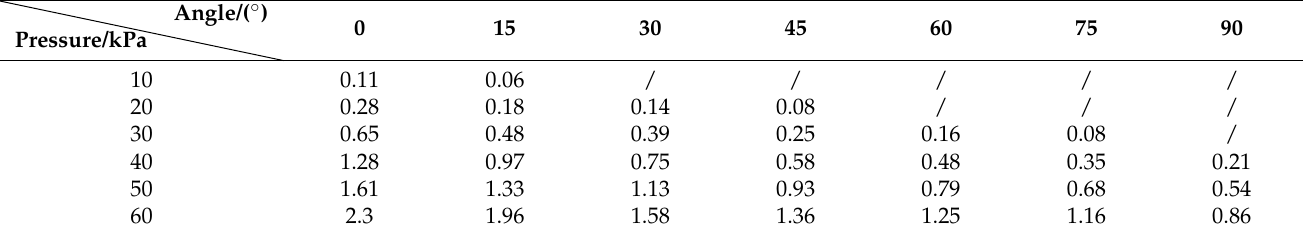
Table 2. Output force at the end of the soft actuator with constraint rings (F/N). Angle/( ◦ Pressure/kPa